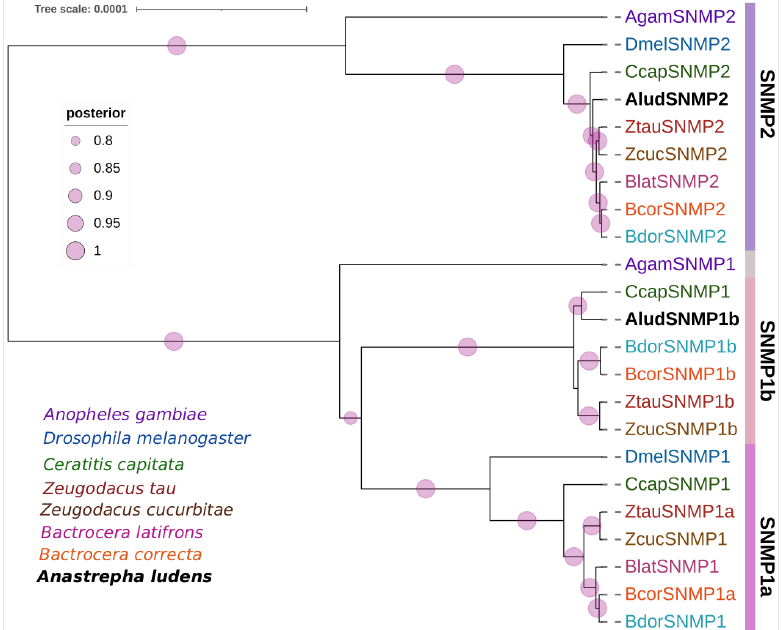
Figure 4. Bayesian phylogenetic analysis of candidate SNMPs from Anastrepha ludens with homologs from seven dipteran species and the model organism Drosophila melanogaster . Bars delimit clusters of AludSNMPs and their orthologues. Circles showed posterior probability values higher than 70%.